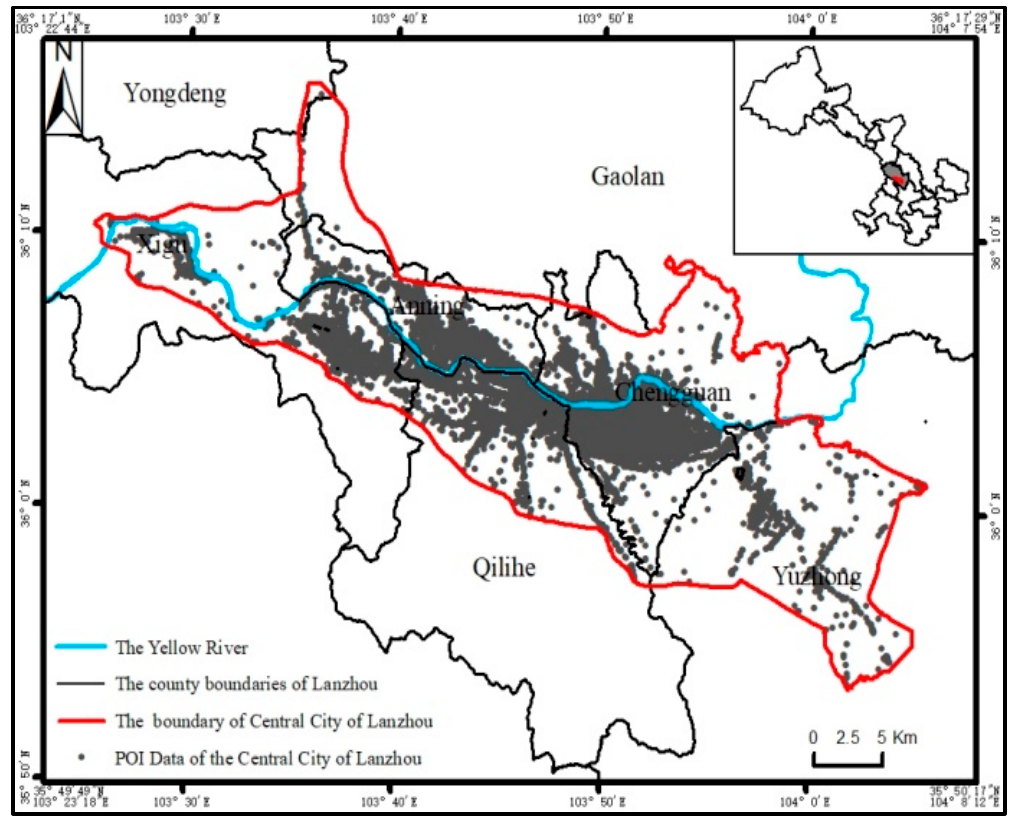
Figure 2. Map of case area.